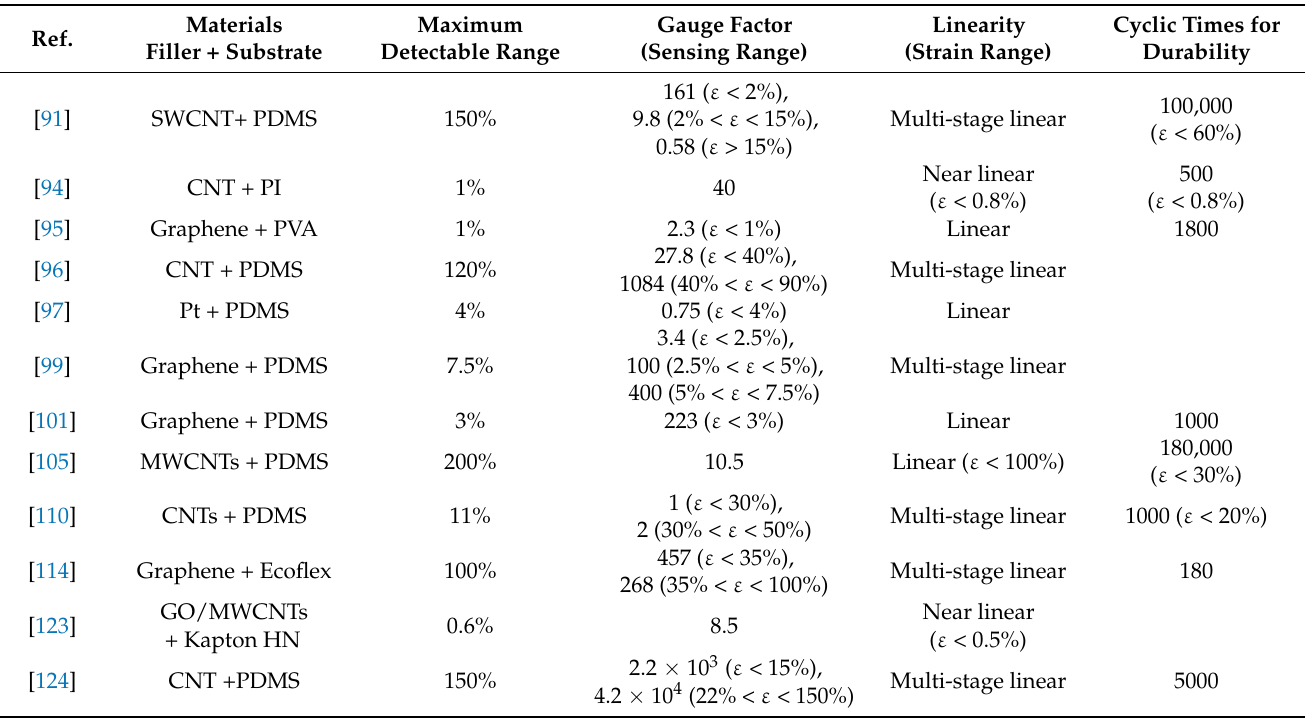
Table 3. Flexible strain sensor with improved sensing performance (‘ ε ’ is strain).